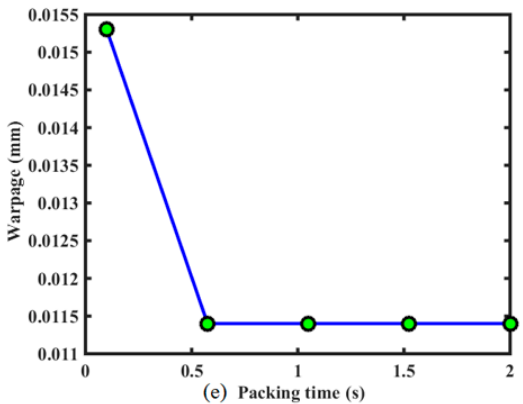
Figure 10. The effect of each design variable on the warpage, when fixing other variables at their optimal values: ( a ) the effect of mold temperature on the warpage of stent; ( b ) the effect of melt temperature on the warpage of stent; ( c ) the effect of flow rate on the warpage of stent; ( d ) the effect of packing pressure on the warpage of stent; ( e ) the effect of packing time on the warpage of stent.